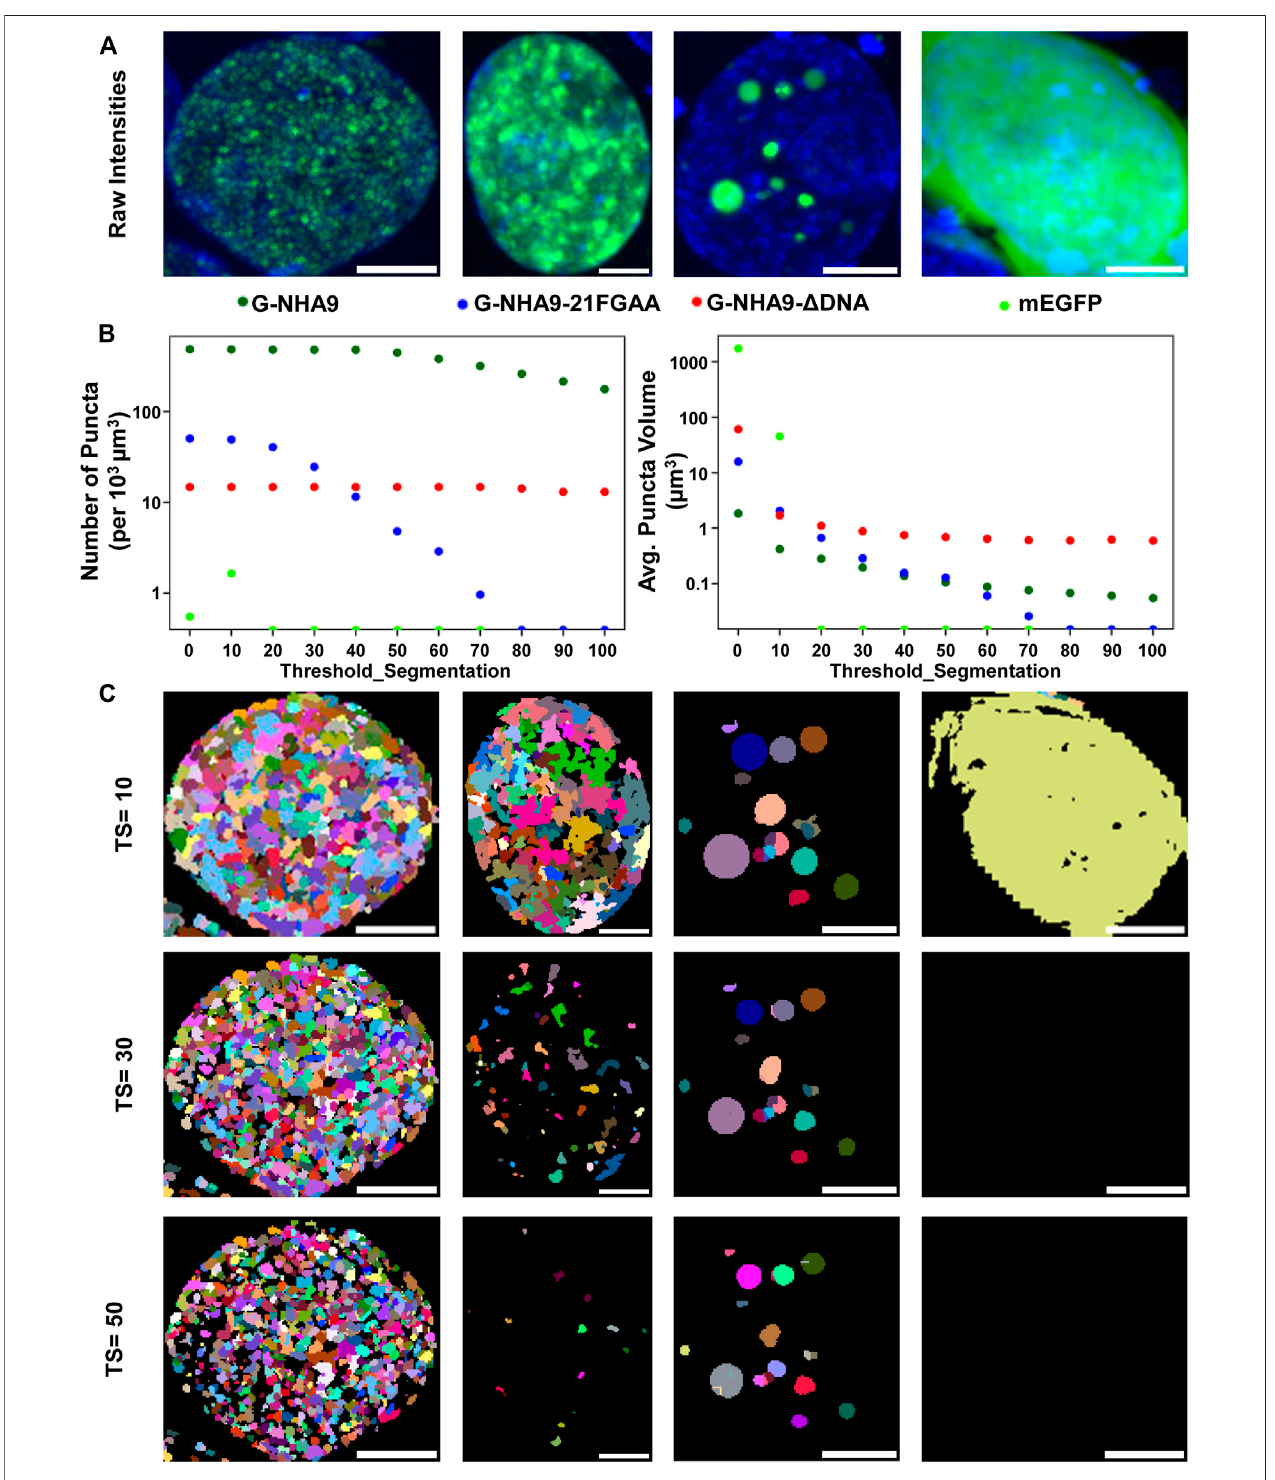
FIGURE 4 | Impact of the “ threshold_segmentation ” parameter on the number and volume of detected puncta. (A) Example cells expressing the G-NHA9 (left), G-NHA9-21FGAA (second from left), and G-NHA9- Δ DNA (second from right) constructs with different sizes of puncta; mEGFP (right) is the negative control. (B) Plots showing how extracted features such as average number of puncta per cell (left) and average volume of puncta per cell (right) change with differing segmentation parameters. (C) Puncta segmentation masks generated with different threshold_segmentation (TS) values. Scale bars show 5 µm. Puncta segmentation was performed using mode 1, default LoG parameters (num_sigma = 5, minsize_um = 0.2, maxsize_um = 2) and a threshold detection value of 0.002 to identify potential puncta centers. Images are shown as maximum intensity z-projections. Full z-stacks including 3D segmentation can be found in the supplemental fi les.